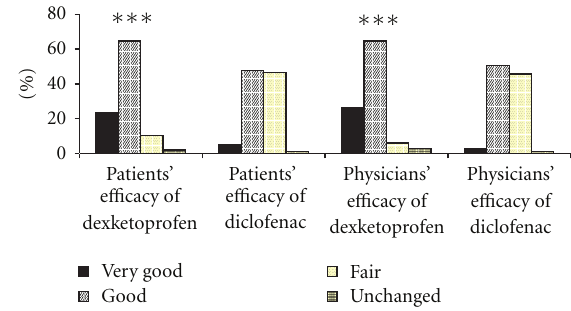
Figure 2: Patients’ and physicians’ global assessment of e ffi cacy ∗∗∗ P < . 0001 with Fisher’s exact test for proportions between (very good + good) versus (fair +